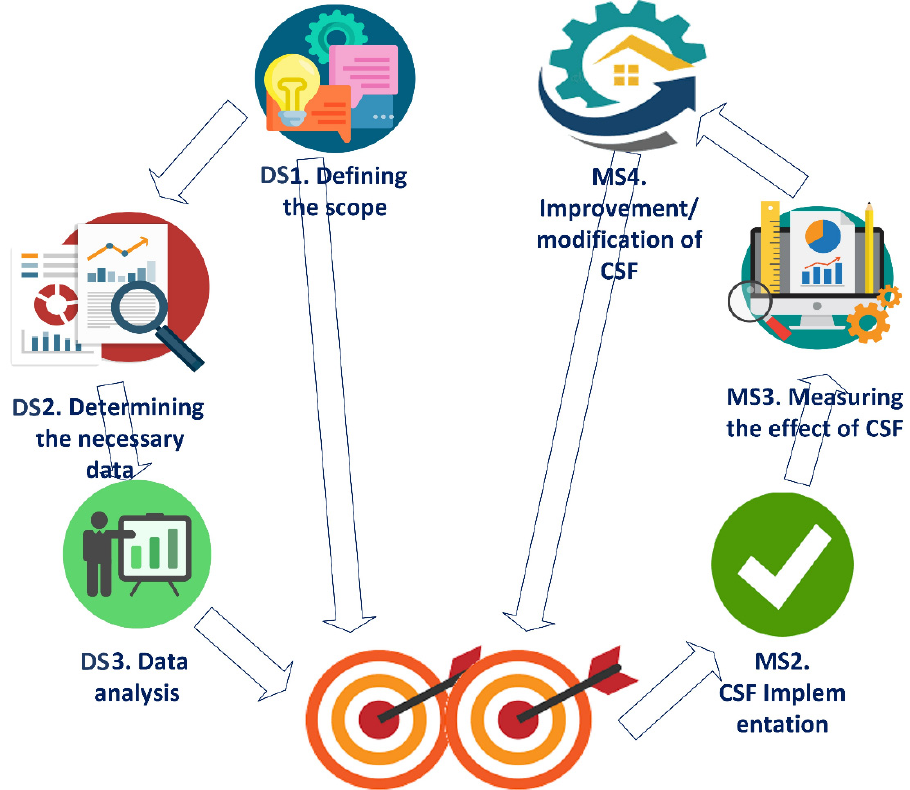
Figure 8. Methodology for application of the framework for design and monitoring of